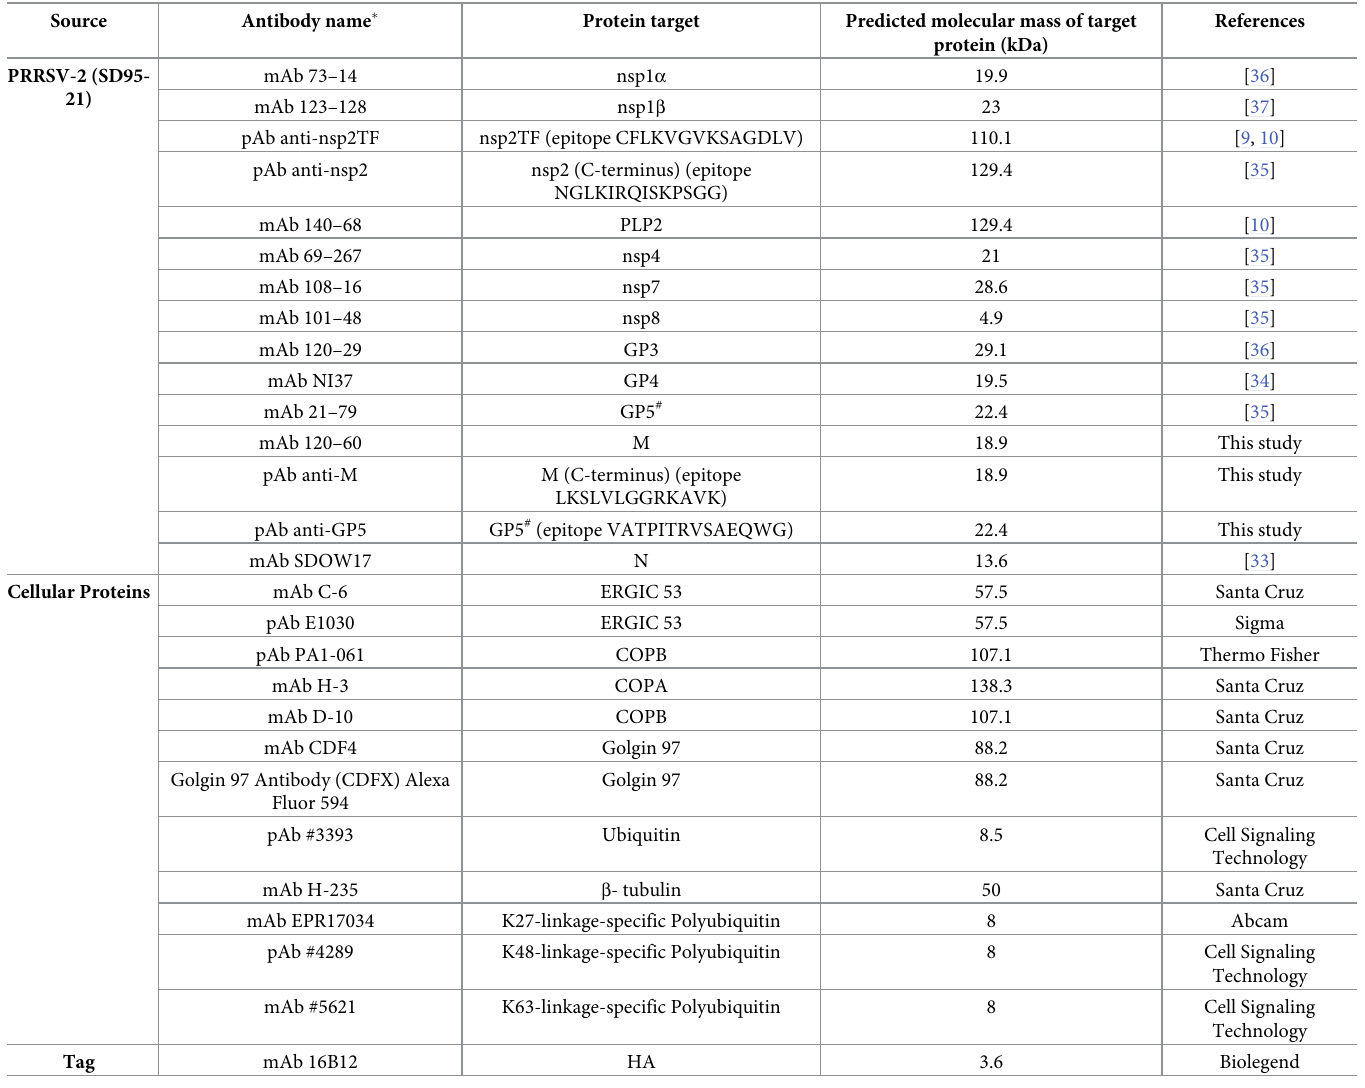
Table 1. List of primary antibodies used in this study.